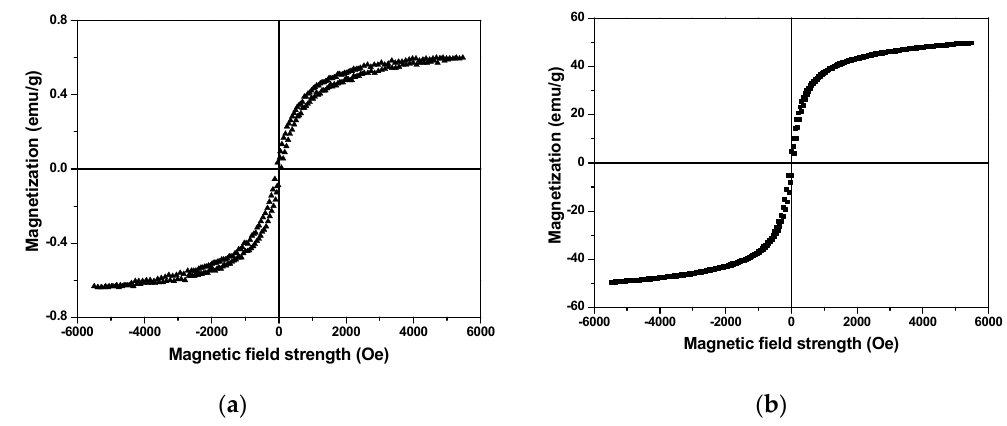
Figure 2. Magnetization versus magnetic field strength curve of ( a ) Portland cement and ( b ) nano-Fe 3 O 4 particles.